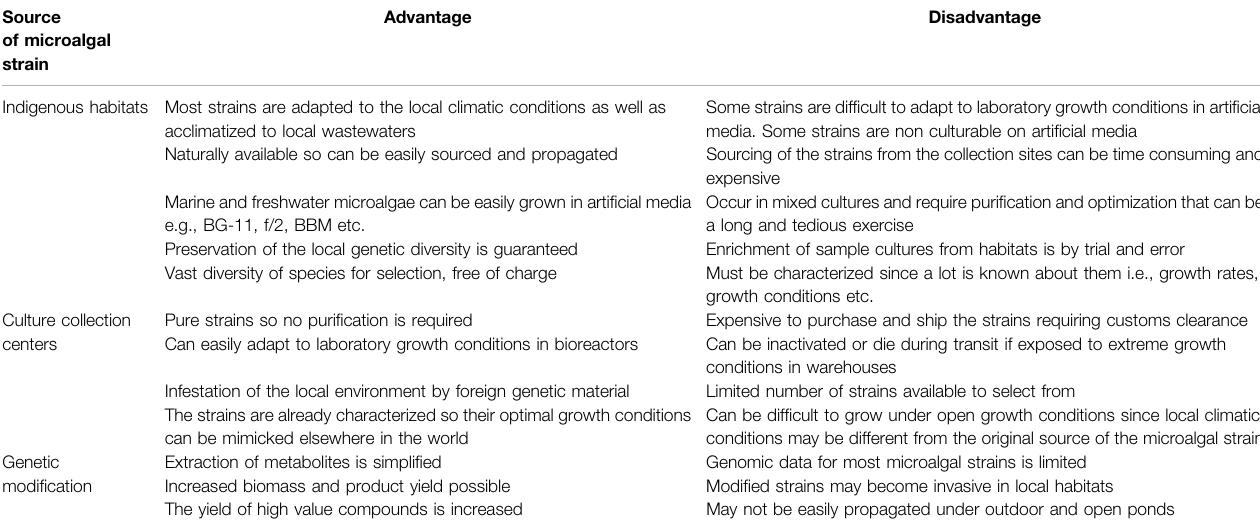
TABLE 1 | Advantage and disadvantages of microalgal strains obtained from indigenous natural aquatic habitats compared to other culture sources (Wilkie et al., 2011). Source of